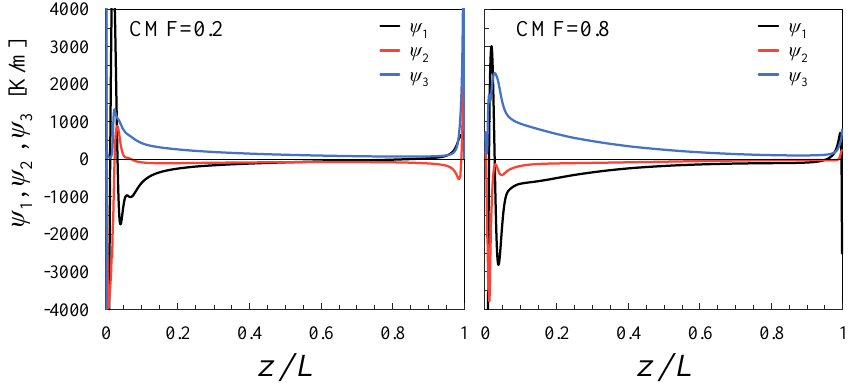
Figure 12. Distributions of ψ 1 , ψ 2 , and ψ 3 along the axial-direction line at r / R = 0.8.